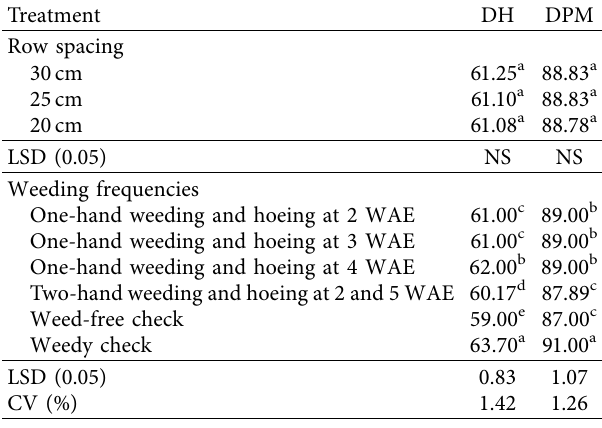
Table 4: Main effect of row spacing and weeding frequencies on phenological and growth parameters of rice at Kuja in 2020 main cropping